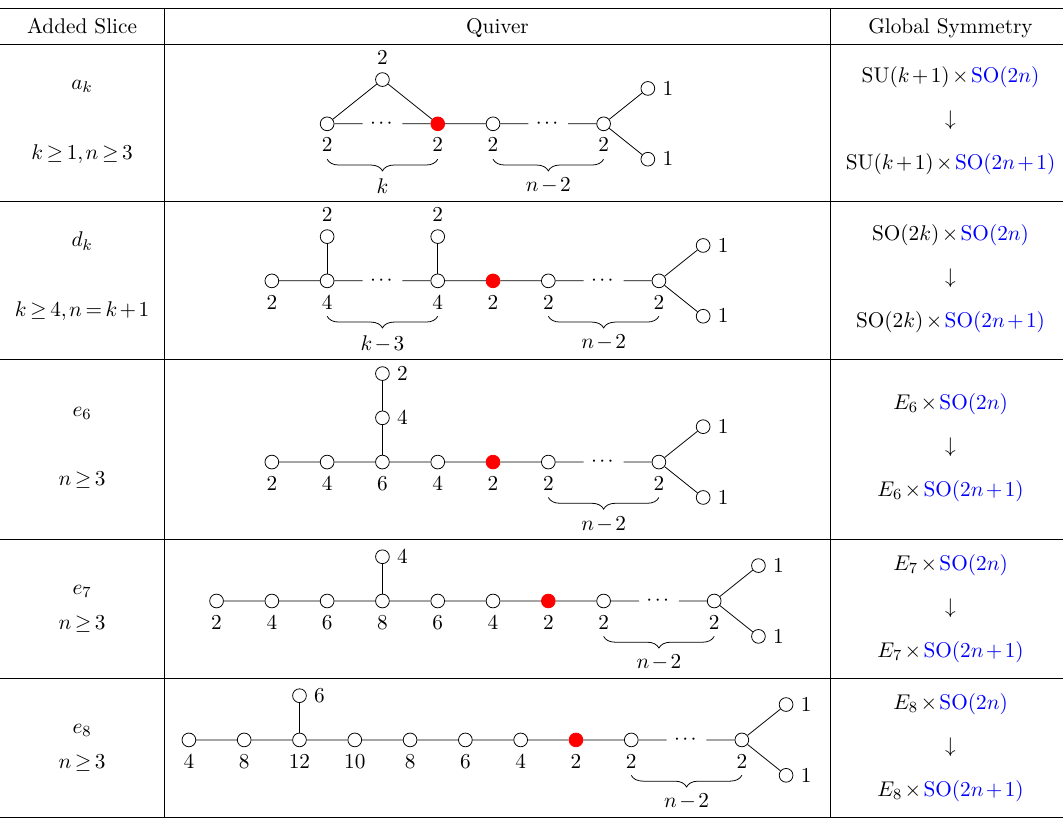
Table 8 . Quivers resulting from adding all possible simply laced elementary slices to the empty nodes of n.min B (4.1) to absorb a , n ≥ 3 n